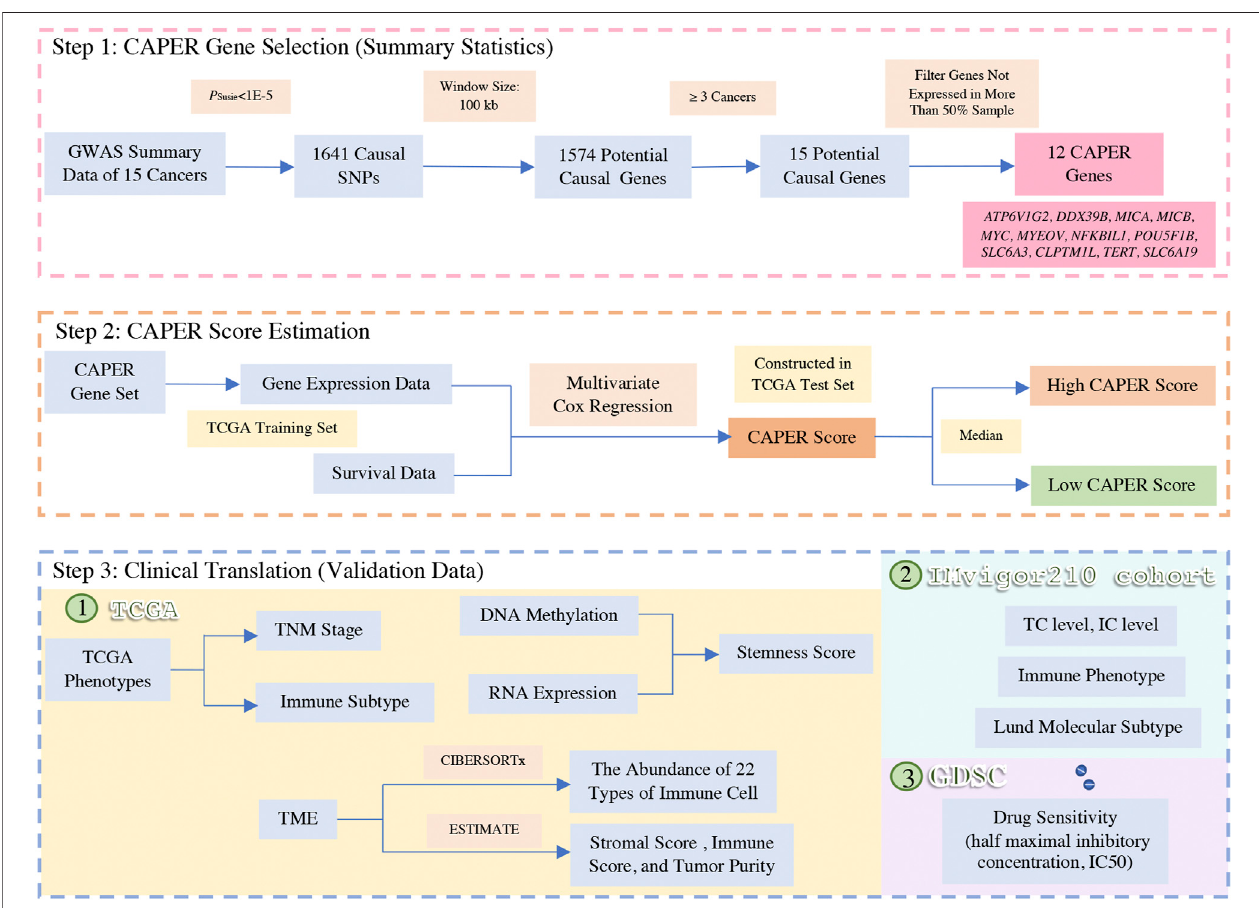
FIGURE 1 | Work fl ow for CAPER score construction and its clinical